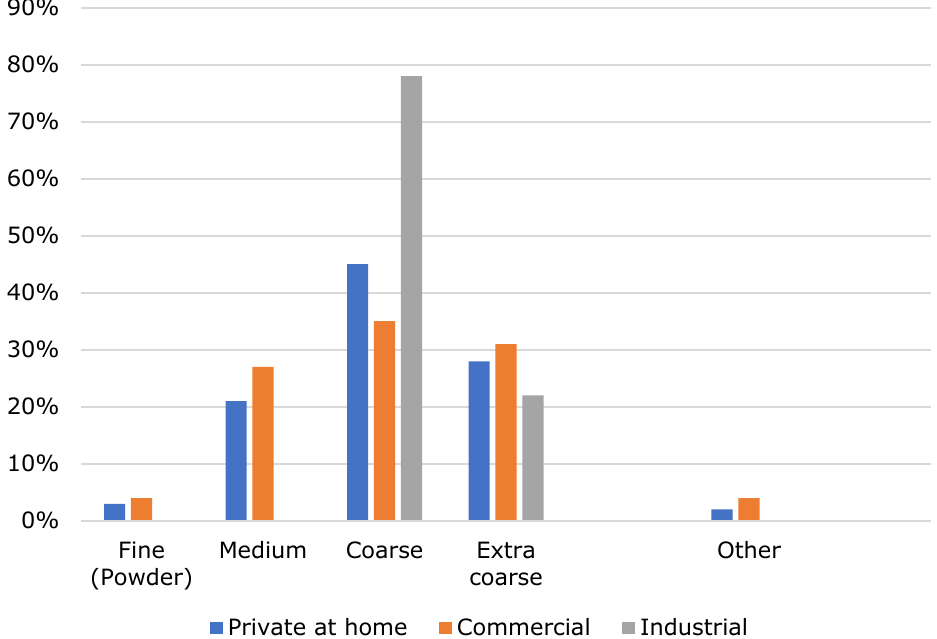
Figure 3. Extraction time of cold brew coffee. As can be seen in Figure 4, coarsely ground coffee is mainly used in each group (home, commercial and industrial). Fine ground coffee is used the least.